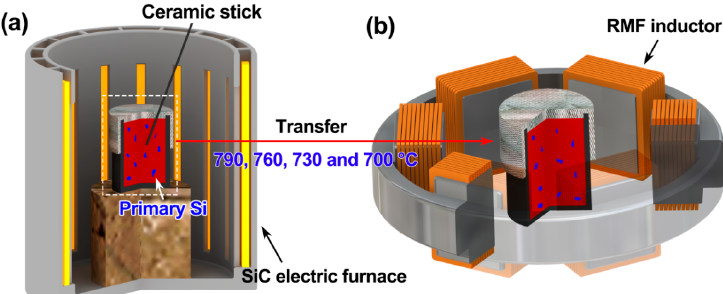
Figure 2. Experiment flow chart of the formation process of the Si-rich layer: ( a ) Cooling with furnace, ( b ) RMF inductor.